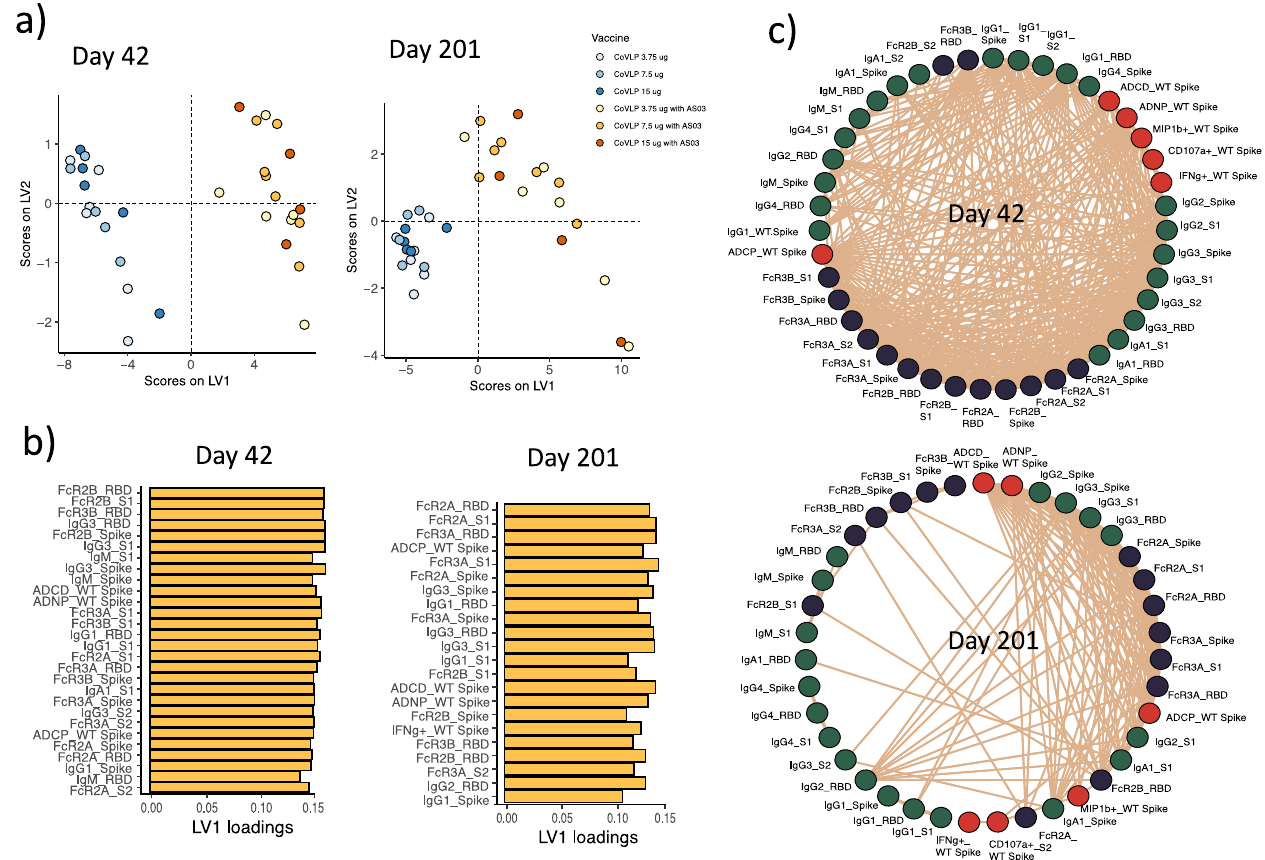
Fig. 2 CoVLP adjuvanted with AS03 triggers robust antibody response to various wild-type SARS-CoV-2 antigens. a , b A Least Absolute Shrinkage Selection Operator (LASSO) was used to reduce the feature dimensionality and ultimately select antibody features that discriminated between vaccinees that received the CoVLP with AS03 (yellow, n = 17) and CoVLP without AS03 (blue, n = 16). a The partial least square discriminant analysis (PLS-DA) was then used to visualize the separation between the samples based on the LASSO selected features, where each dot represents an individual vaccine. b The bar graph shows the ranking of the LASSO selected features based on a Variable of Importance (VIP) score. c The network analysis shows the additional antibody features that were correlated with the LASSO selected features, thus likely to be as important in driving the separation. The network was built using a threshold of absolute Spearman rho <0.7 and a BH- adjusted p -value lower than 0.01. Nodes were colored based on the type of measurement: antibody titers (green), FcRs binding (black), and antibody-mediated effector functions (red). The connecting lines denote all positive correlations (no negative correlations were